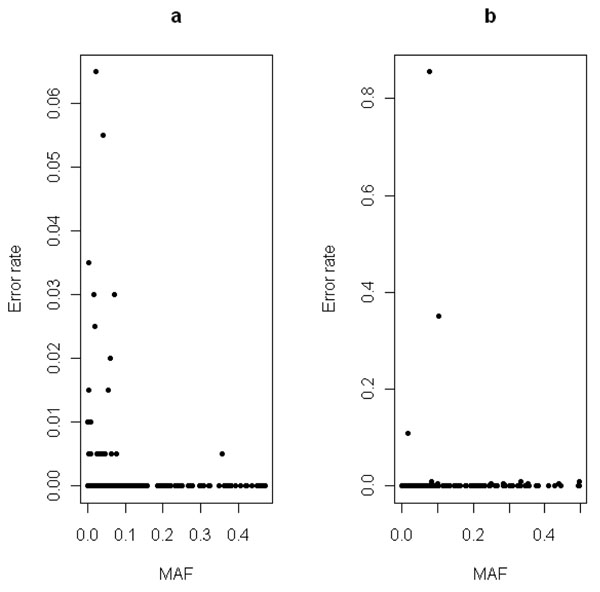
Marker-specific error rates. Marker-specific error rates as a function of minor allele frequency (MAF) for all nonfunctional markers. (a) MB-MDR using max T on unrelated individuals and (b) PBAT with default options.